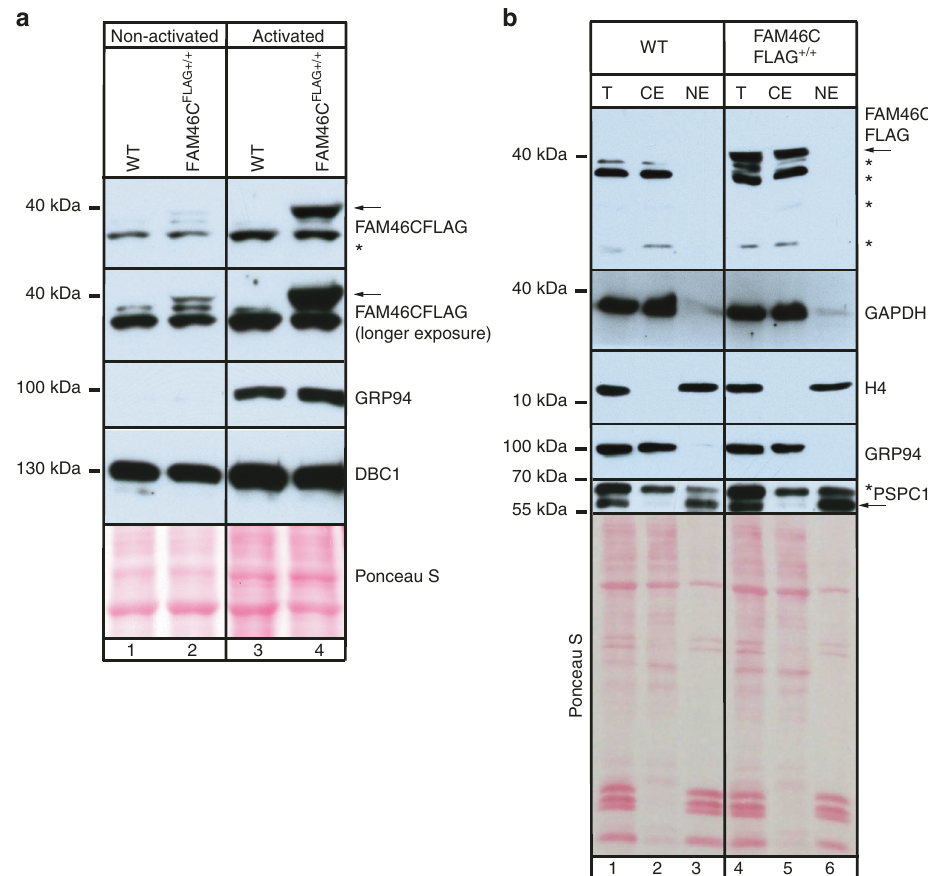
Fig. 5 FAM46C is induced in activated B lymphocytes and localizes mainly in the cytosol. a Splenocytes from FAM46C -FLAG + / + knock-in mice and control animals were isolated and then cultured in presence of IL4 and LPS for 72 h. The level of FAM46C-FLAG was checked by western blot in non-activated (lanes 1 – 2) and activated (lanes 2 – 4) cells. GRP94 was used as activation marker, while DBC1 was used as a loading control. b Endogenous FAM46C localizes mainly in the cytosol. Splenocytes from WT and FAM46C -FLAG + / + mice were isolated and fractionated. The whole-cell (T), cytoplasmic (CE), and nuclear (NE) extracts were analyzed by western blot. FAM46C-FLAG was detected using an anti-FLAG antibody. GAPDH and GRP94 were used as a cytosolic markers, while histone H4 and PSPC1 were used as nuclear markers. Arrow indicates the position of FAM46C-FLAG, while asterisks indicts nonspeci fi c bands detected by antibodies, which were present in samples isolated from both WT and FAM46C-FLAG